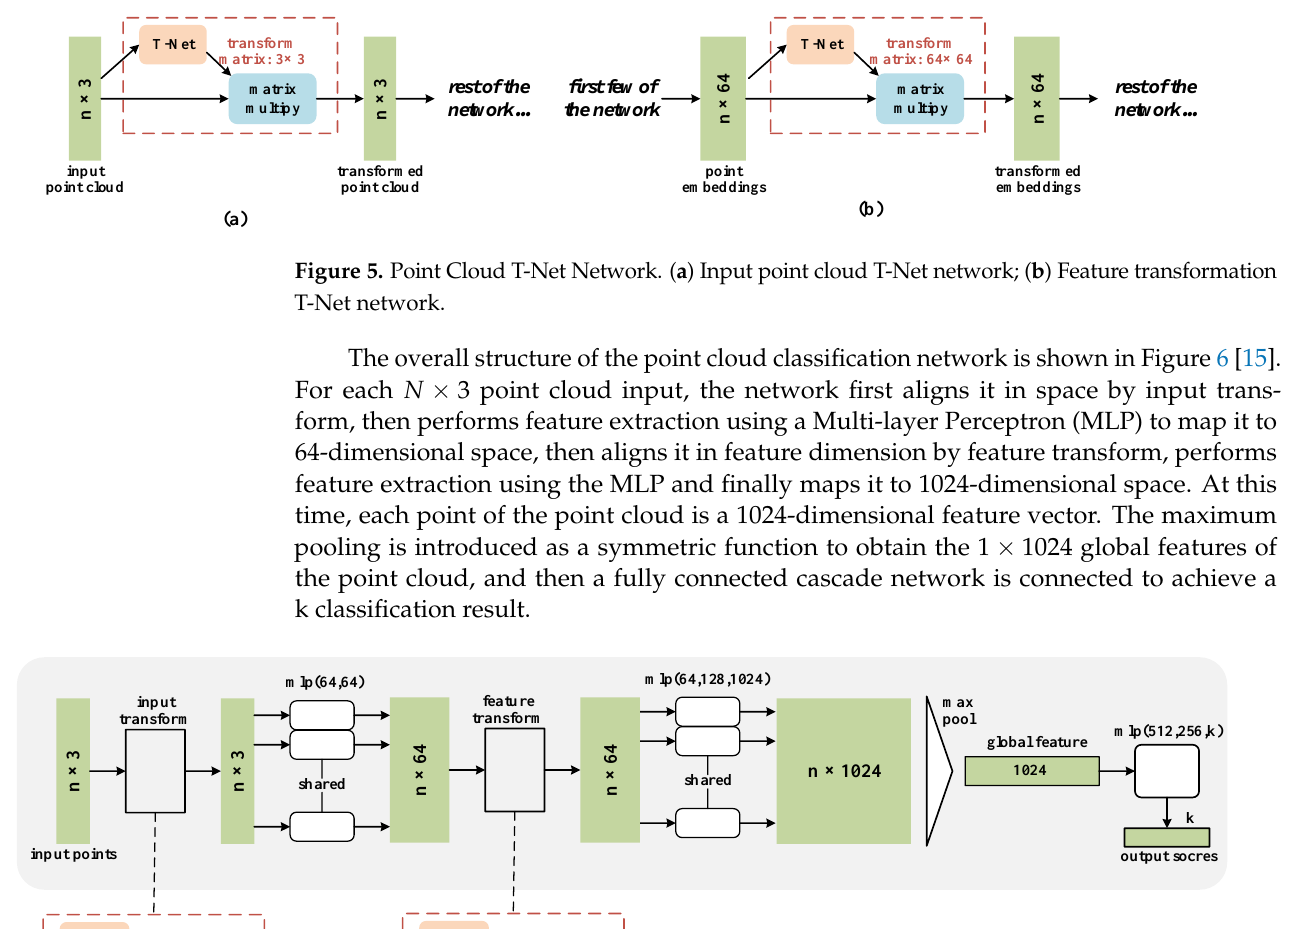
Figure 5. Point Cloud T-Net Network. ( a ) Input point cloud T-Net network; ( b ) Feature transfor- mation T-Net network.